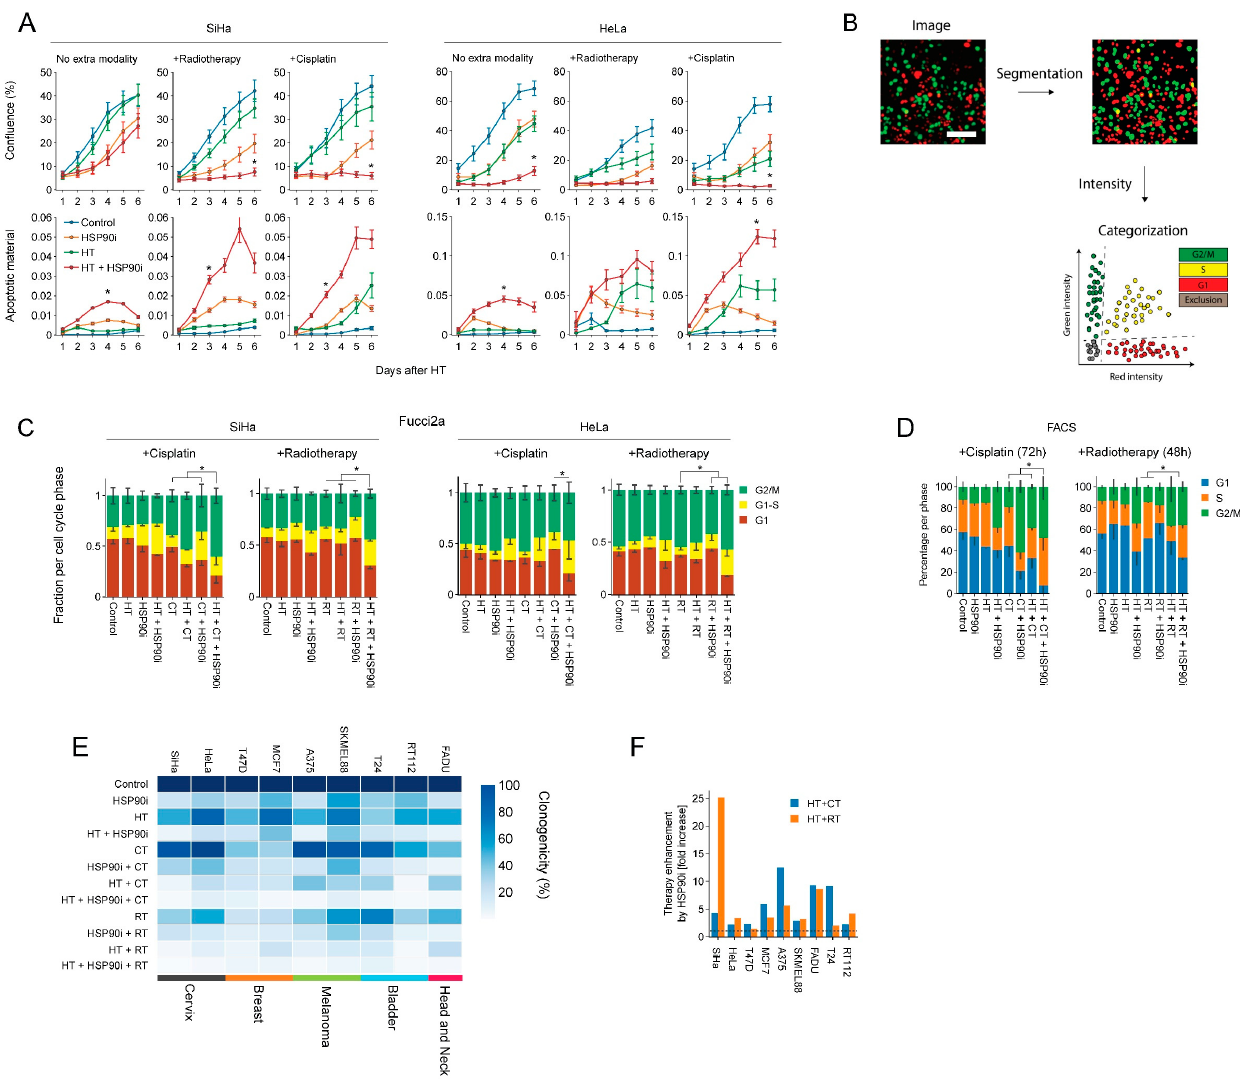
Figure 2. Ganetespib improves the efficacy of hyperthermia-based treatments in vitro. Cervix cancer cells were exposed to combinations of hyperthermia (HT), 30 nM of ganetespib (HSP90i), 2 Gy of radiotherapy (RT), and 3.3 µ M of cisplatin (CT). ( A ) Cell growth and apoptosis were monitored and quantified over the course of six days with the IncuCyte S3 imaging platform. Noteworthy significant differences are marked with an asterisk. ( B ) Cell cycle analysis pipeline after radio- and chemo- thermotherapy using Fucci2a-transfected cervix cancer cells. Cells were imaged daily after treatment, and image segmentation was performed, followed by quantification of fluorescence intensities and thresholding to detect cells in the different phases of the cell cycle. Scale bar: 100 μ m ( C ) Quantification of cell cycle distribution after radio- and chemo-thermotherapy 48 and 72 h after HT, respectively, based on the analysis of cells transduced with the Fucci2a reporter. ( D ) FACS-based cell cycle analysis at identical time points. Noteworthy significant differences between the percent- age of cells in G1 are marked with an asterisk. ( E ) Heatmap showing clonogenicity after radio- and chemo-thermotherapy of a cancer cell line panel. ( F ) Enhancement ratio of chemo- and radio-ther- motherapy outcomes in the presence of ganetespib, displayed as a fold-increase relative to the re- spective treatment without ganetespib. The horizontal dotted line marks no enhancement.